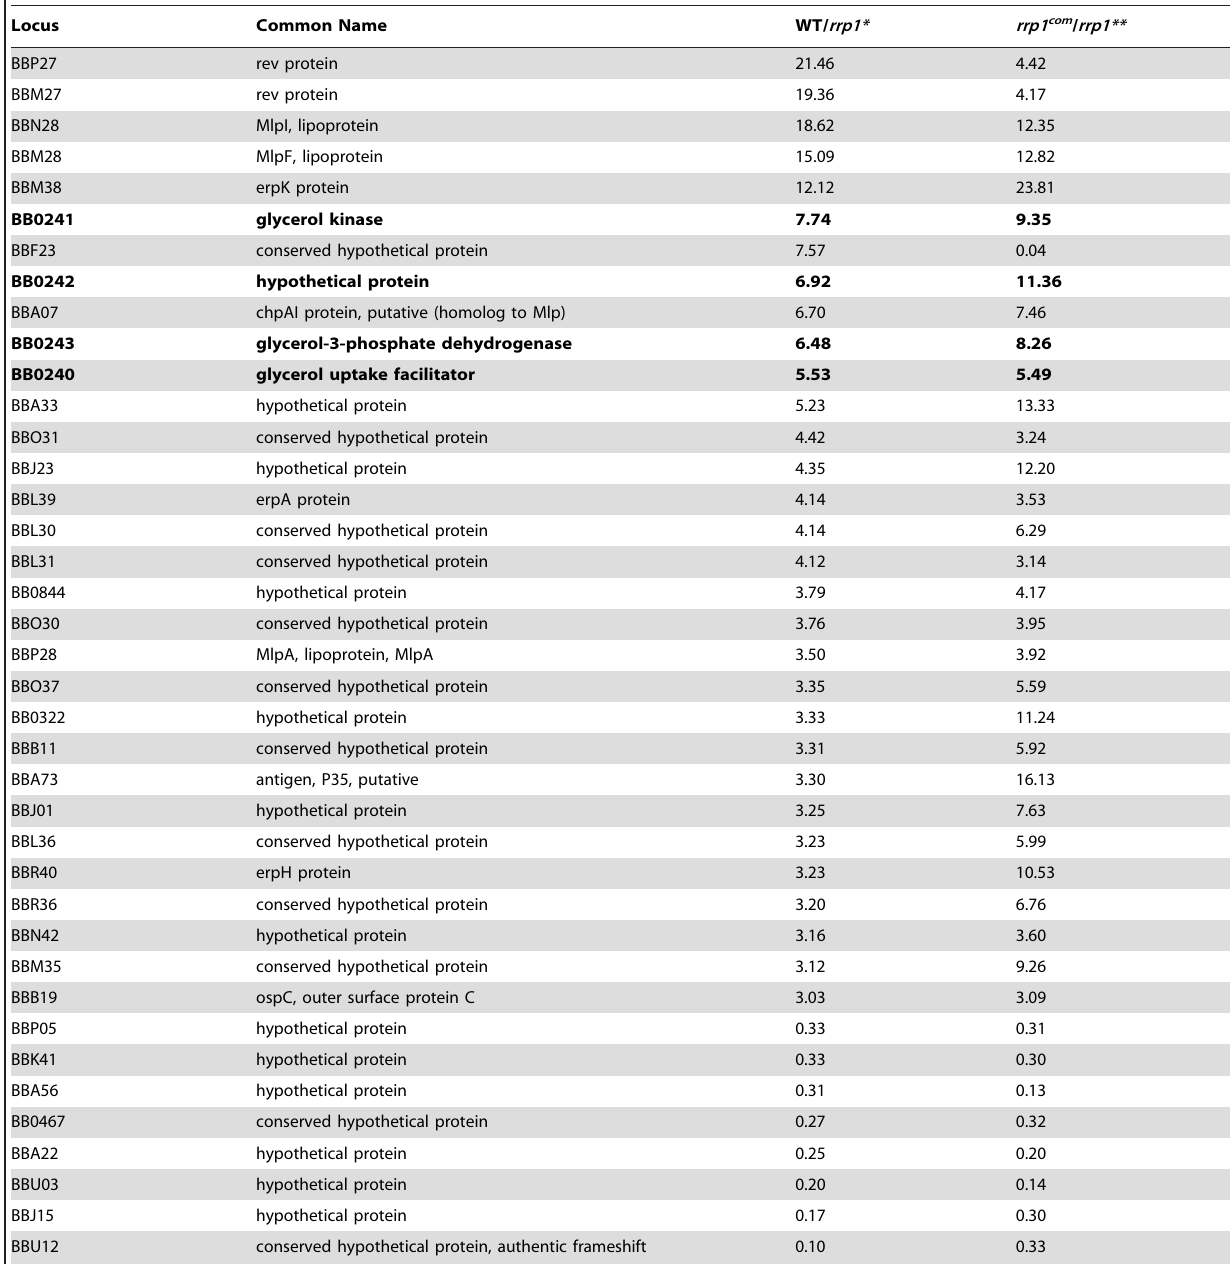
Table 4. Rrp1-regulated genes in B. burgdorferi.